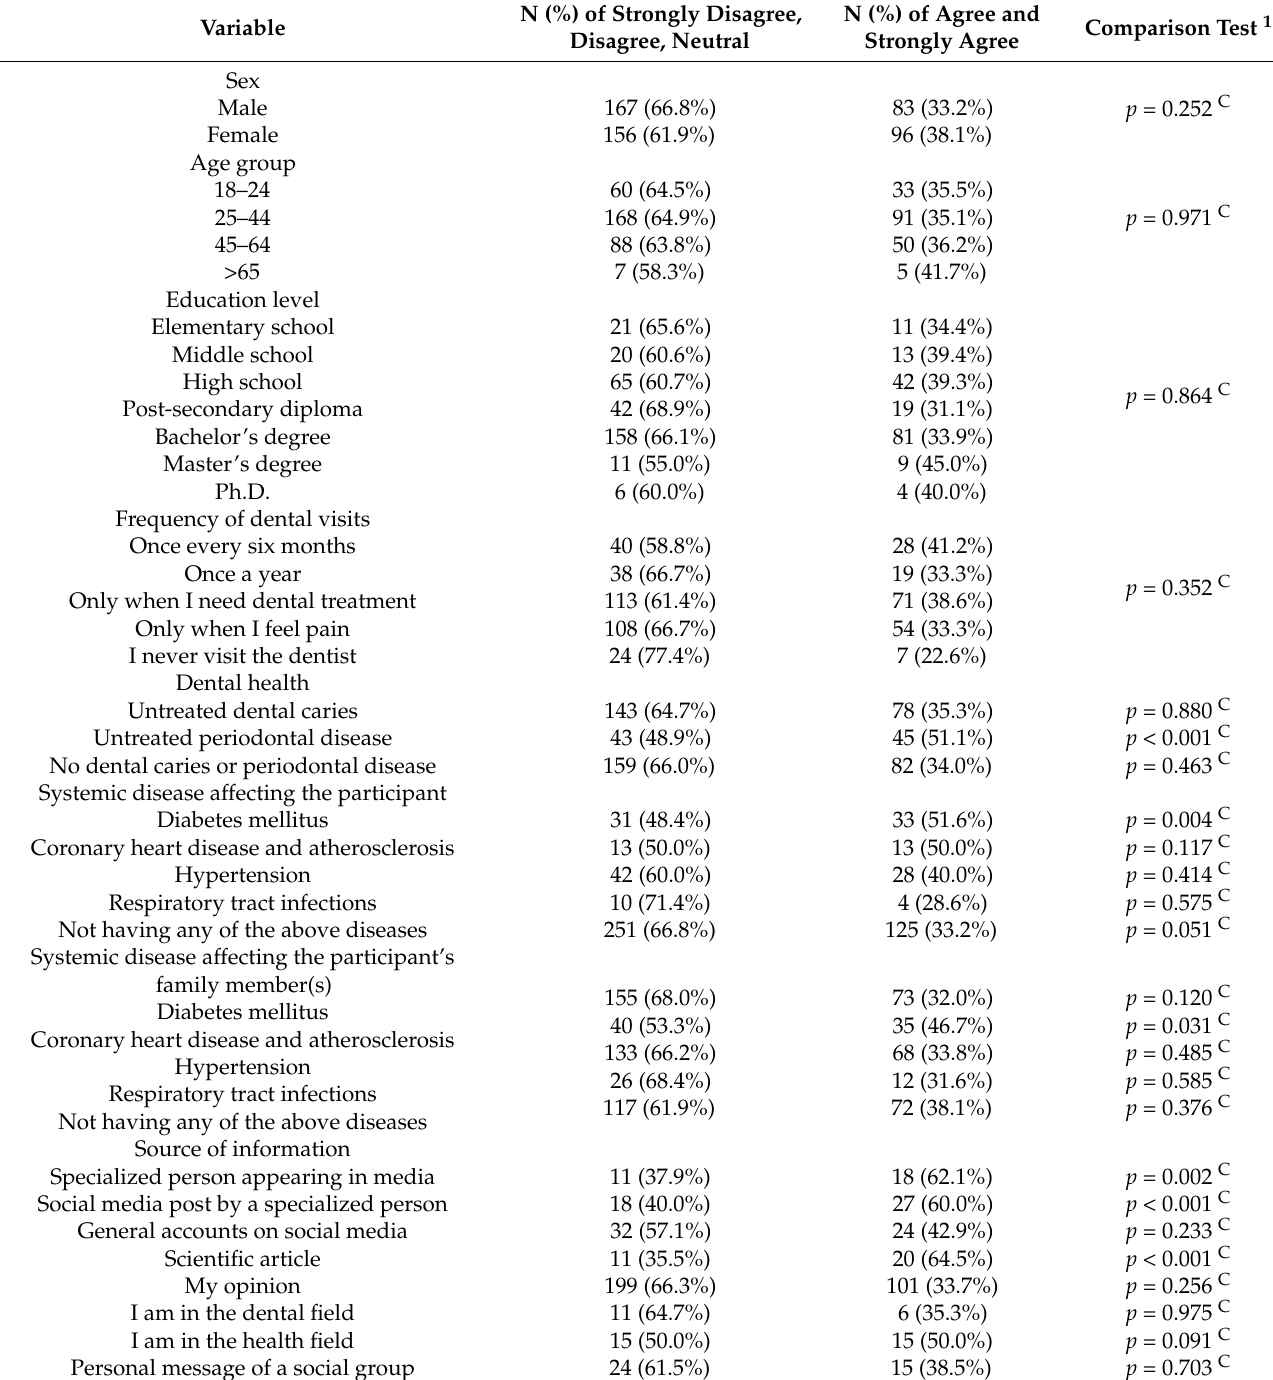
Table 6. Awareness about the association between periodontal disease and diabetes mellitus dis- tributed by various